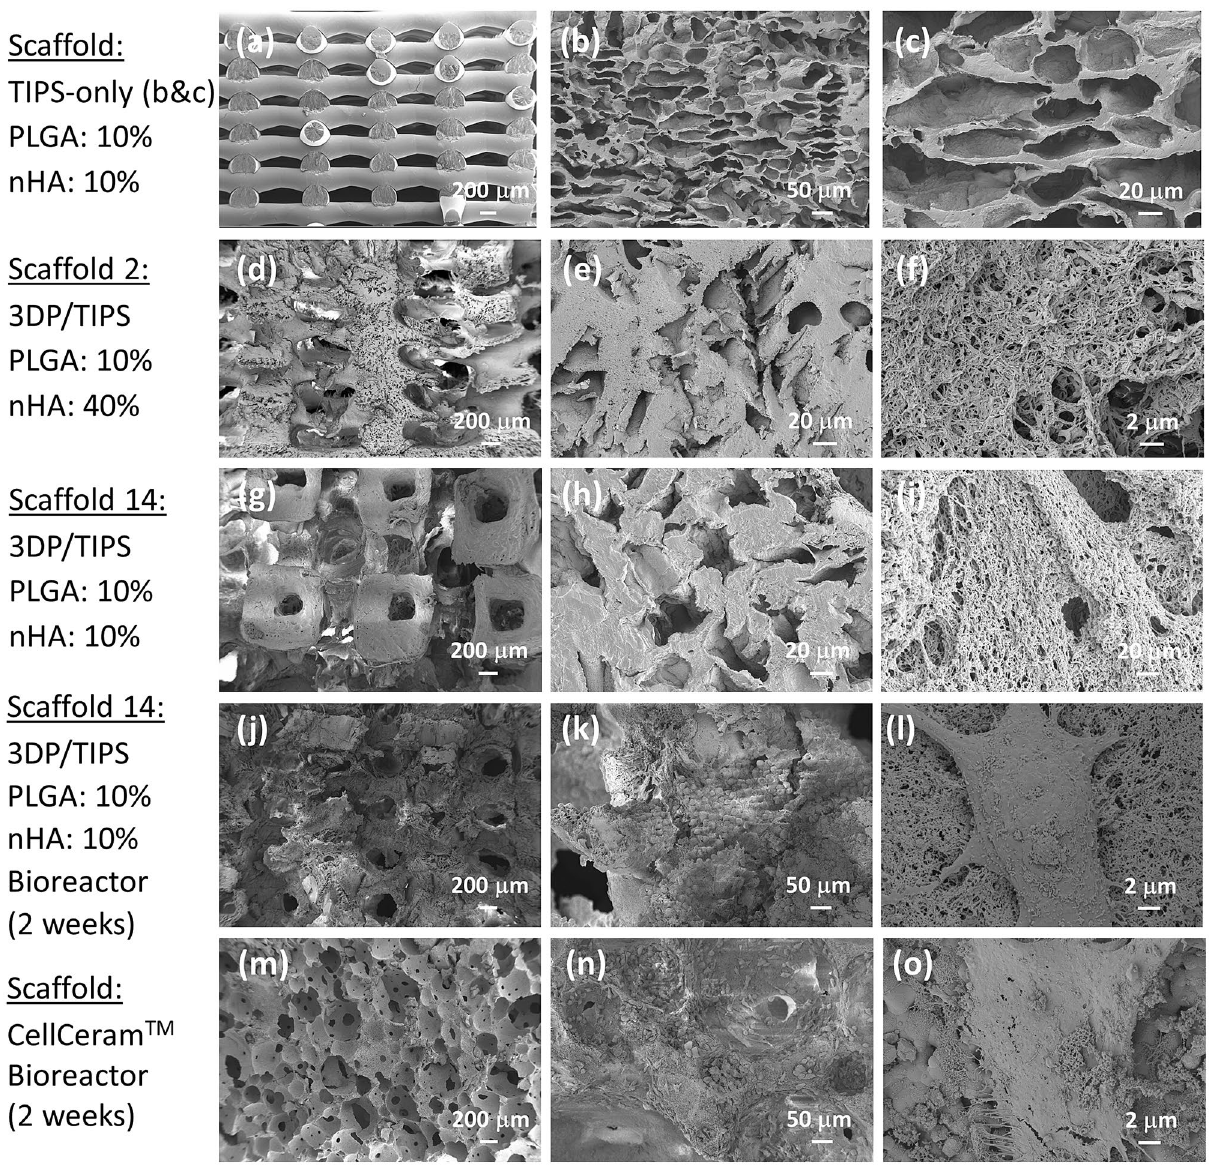
h & i the side views of scaffold #14 prepared using the 3DP/TIPS method, j & k the side views and l the top view of scaffold #14 after 2 weeks of culture inside the bioreactor, and m – o the top views of CellCeram ™ scaffold after 2 weeks of culture inside the